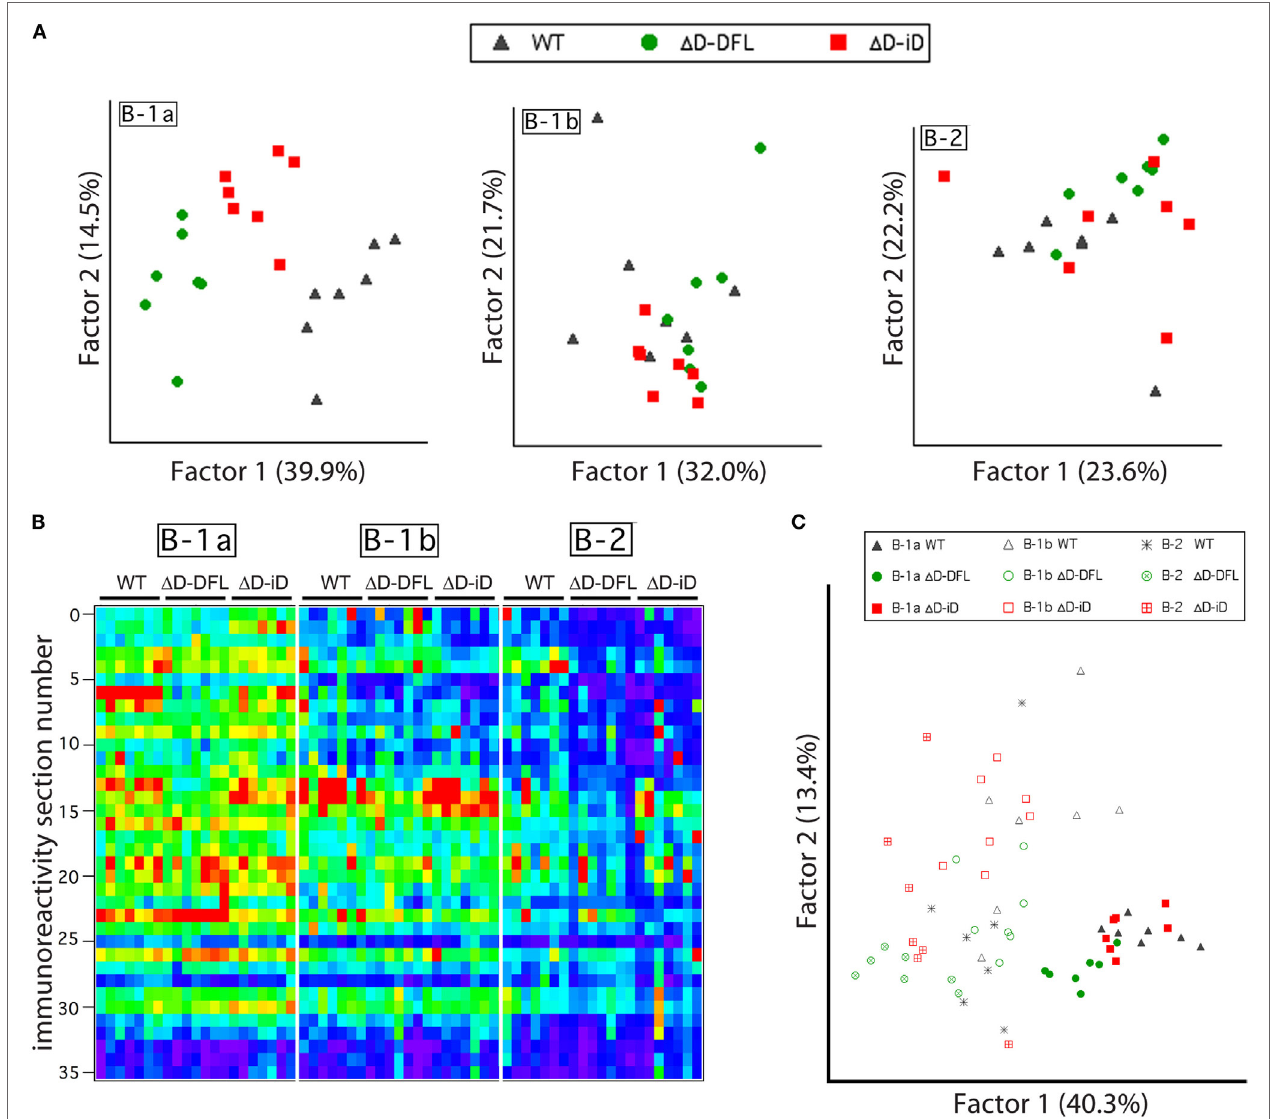
FigUre 6 | B cell subset-intrinsic and genotype-dependent features of the repertoire . (a) Principal component analysis (PCA) of reactivities for each PerC B cell subset discriminates the B-1a genetic alterations of D H sequences in the available repertoire of specificities but not B-1b or B-2 subsets available repertoire. (B) All data from reactivity profiles (B-1a, B-1b, and B-2 subsets from the three mouse strains) are shown on a single heat map indicating similarities between reactivity profiles. (c) Subjecting all data matrix to PCA results in subset characteristics prevailing over genetic distinctions imposed by D H